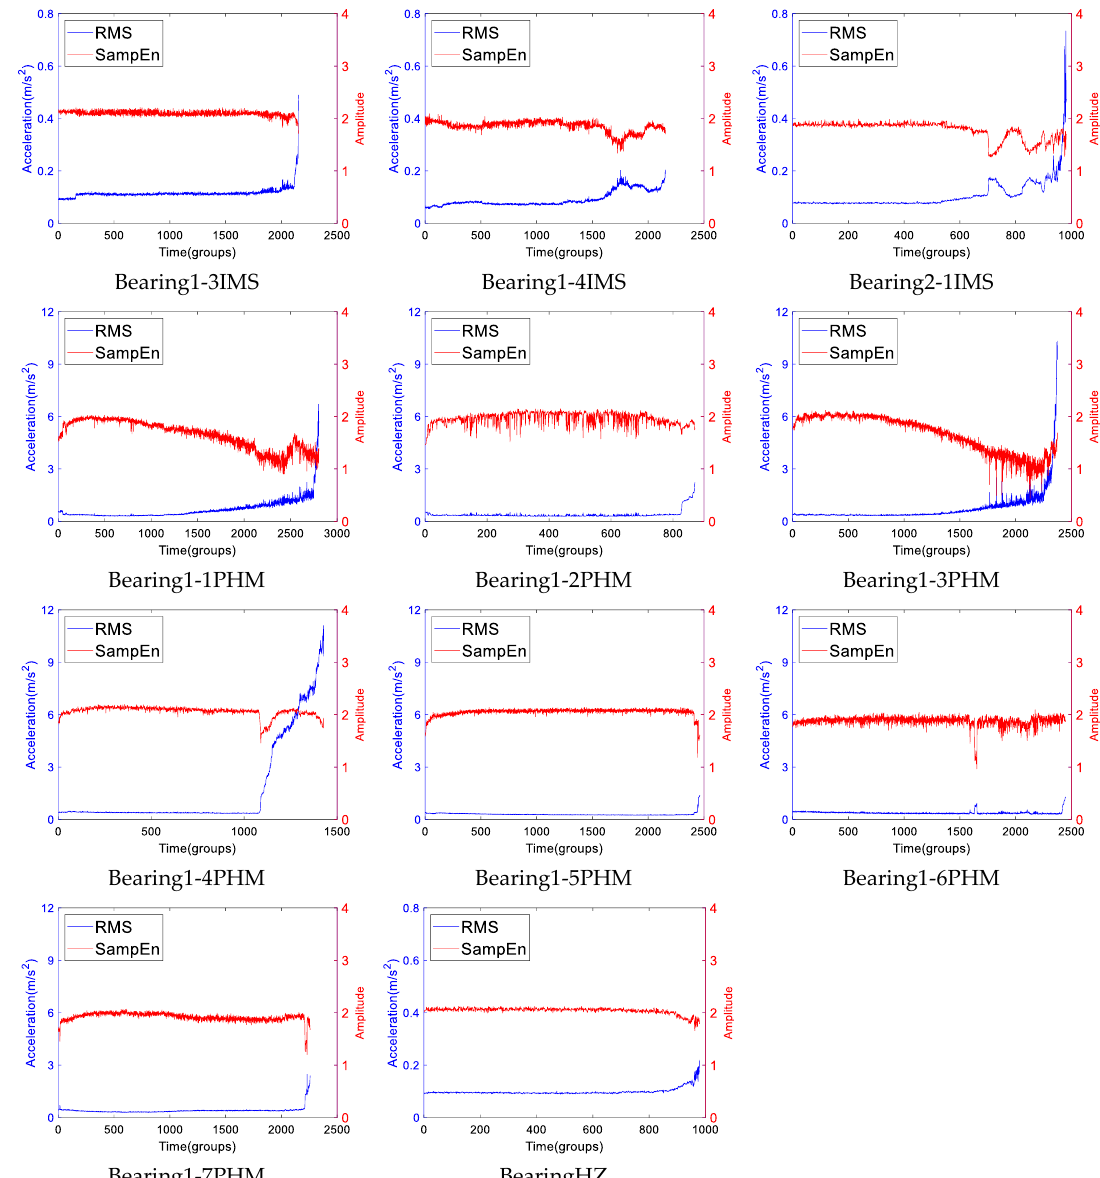
Figure 17. The RMS and SampEn curves of di ff erent run-to-failure rolling bearings’ data. The zero-line stage of the “two-stage” character can be simulated by a straight line. The quick raise stage can be simulated by an exponential function. For the second stage, it is a period that the number and scale of defects are increasing. Cracks are occurred between the adjacent defects and make them merged into a big defect, thus making more spalling. The crack propagation can be estimated by the Paris law which indicates that the rate of crack growth shows exponential form. At this stage, the health indicator is mainly a ff ected by the RMS. The RMS presents an exponential form. So, the exponent can be used to simulate the quickly raise